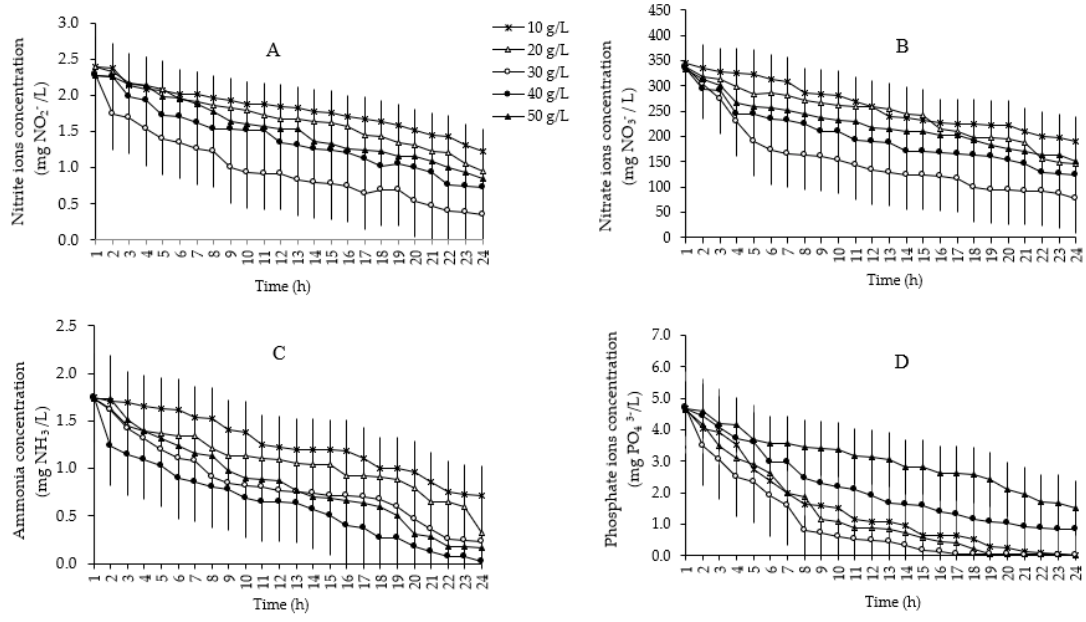
Figure 1. Changes over time in concentrations of nitrite (NO 2– ) ( A ), nitrate (NO 3– ) ( B ), ammonia (NH 3 ) ( C ), and phosphate (PO 43- ) ( D ) with Caulerpa lentillifera at five macroalgal density levels, 30 ppt salinity, without aeration. The error bars indicate standard deviations. n = 3.